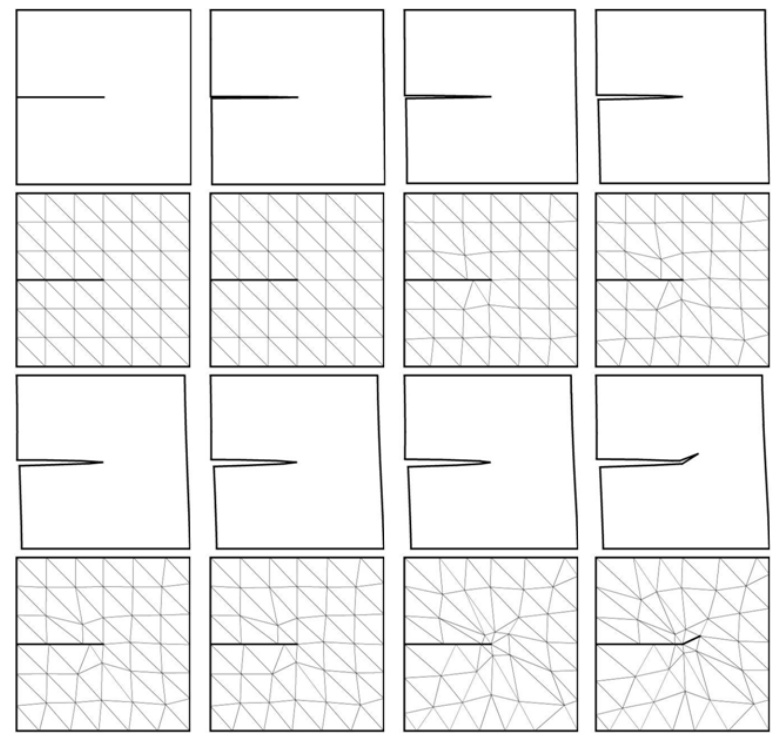
Figure 18: Kinking of a straight crack in mixed mode I & II. Mesh size: L/12 2 . Minimal deformation and modified mesh at 8 time steps. Crack kinking in the last snapshot.